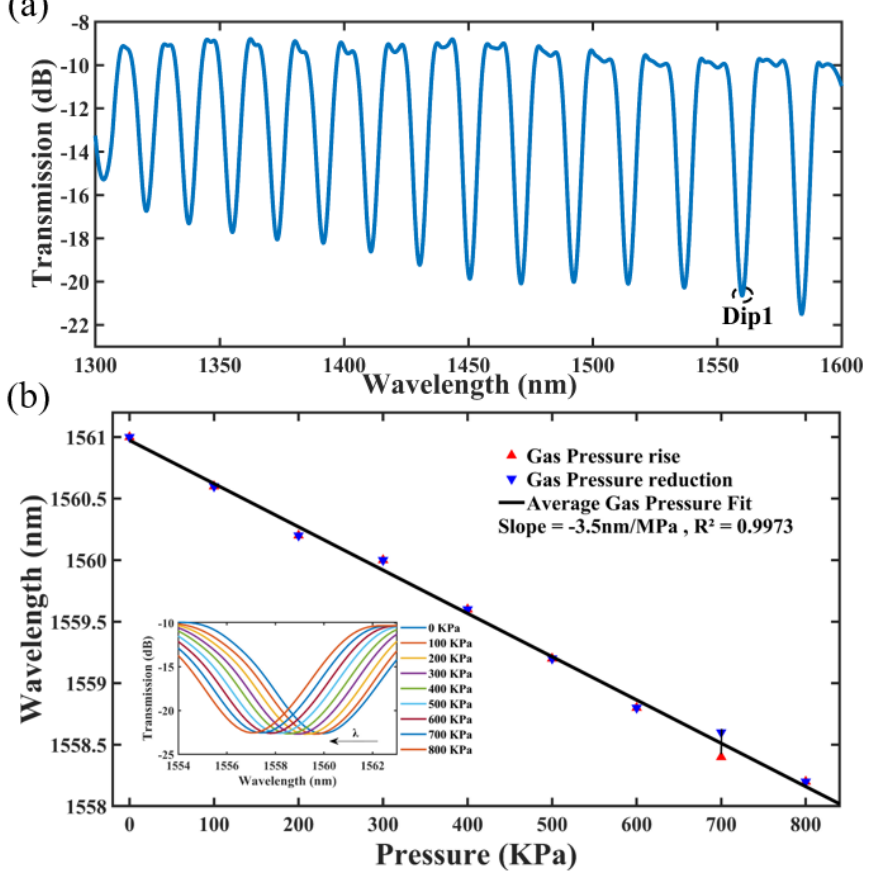
Figure 6. Single-hole sensor for air pressure. ( a ) Initial spectrum; ( b ) Spectral drift and linear